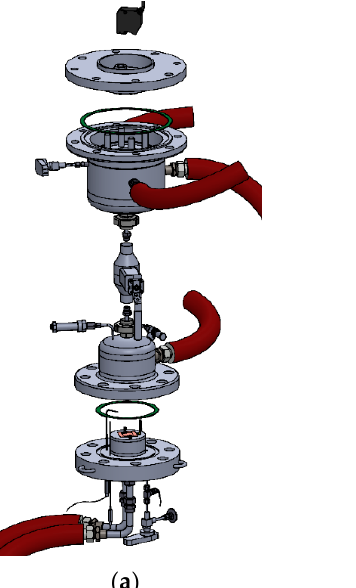
Figure 3. Explosion view ( a ) and photograph ( b ) of the macrokinetic installation.